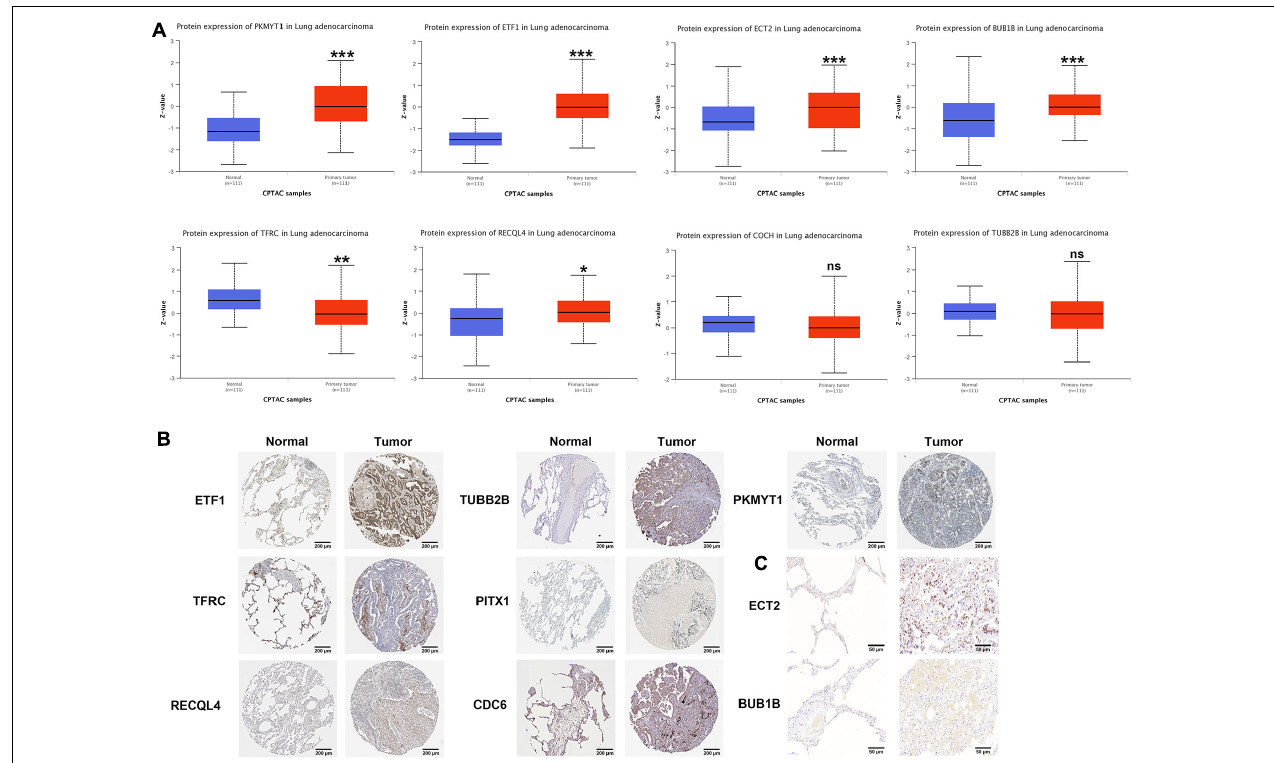
FIGURE 7 | Protein level of CCRGs in LUAC tumor tissues and normal tissues. (A) CPTAC database. (B) HPA database. (C) IHC * P < 0.05, ** P < 0.01, *** P <